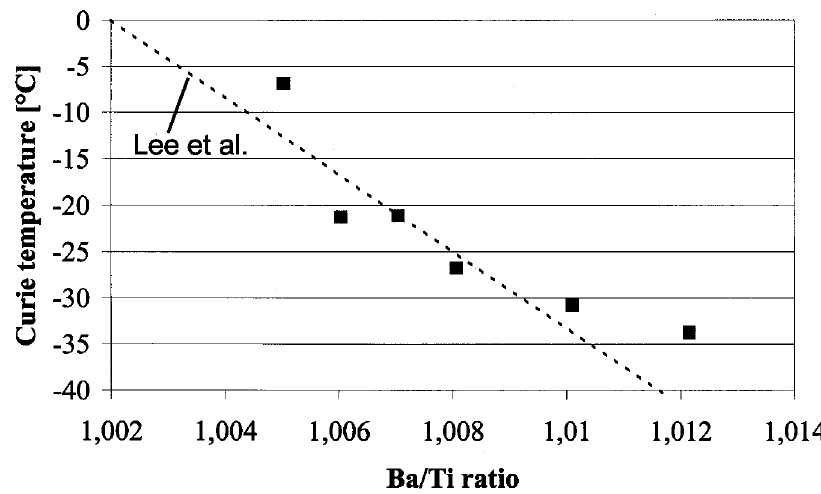
FIGURE 6 Decrease of the Curie temperature with increasing RE-B-site occupation.